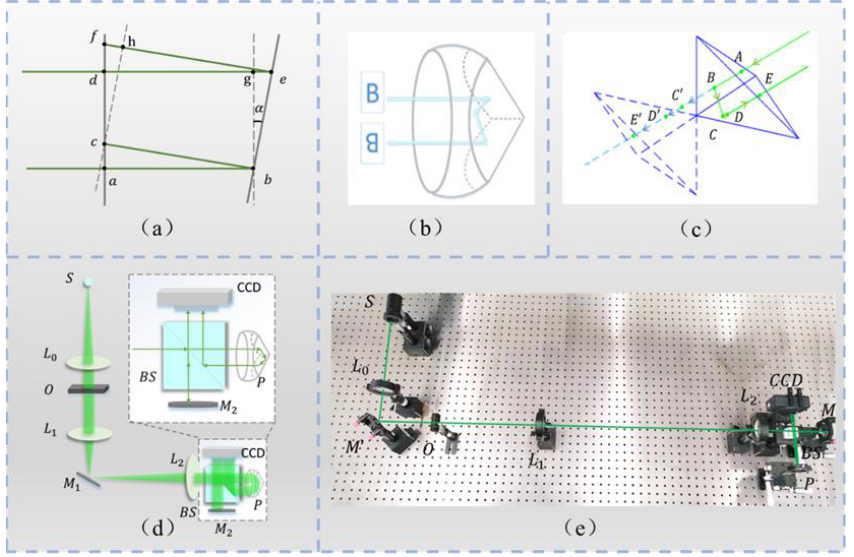
Figure 2. Imaging principle and light path diagram. ( a ) Plane Mirror inclined light path; ( b ) diagrammatic Diagram of Cube Corner Prism; ( c ) diagrammatic Diagram of Cube Corner Prism; ( d ) Light Path Diagram of image acquisition module; and ( e ) Experimental Measurements Light Path Diagram.